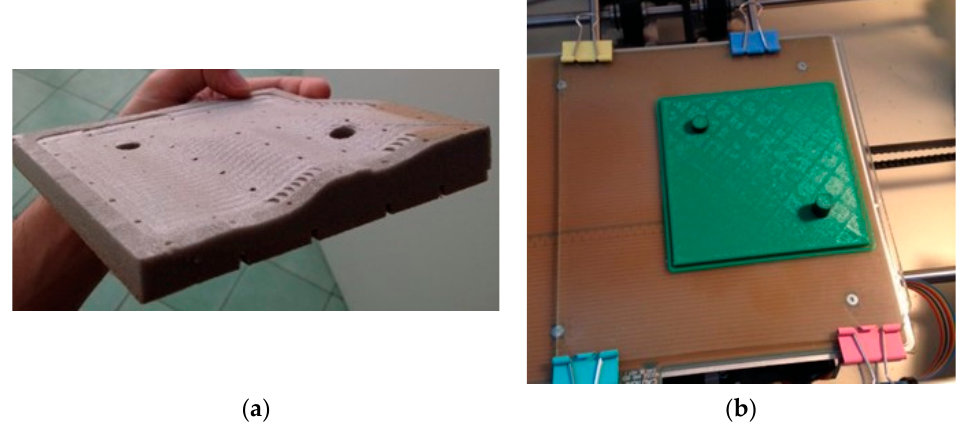
Figure 9. Final prototype manufacturing: ( a ) double ‐ curved milled mould; ( b ) assembly jig in PLA.